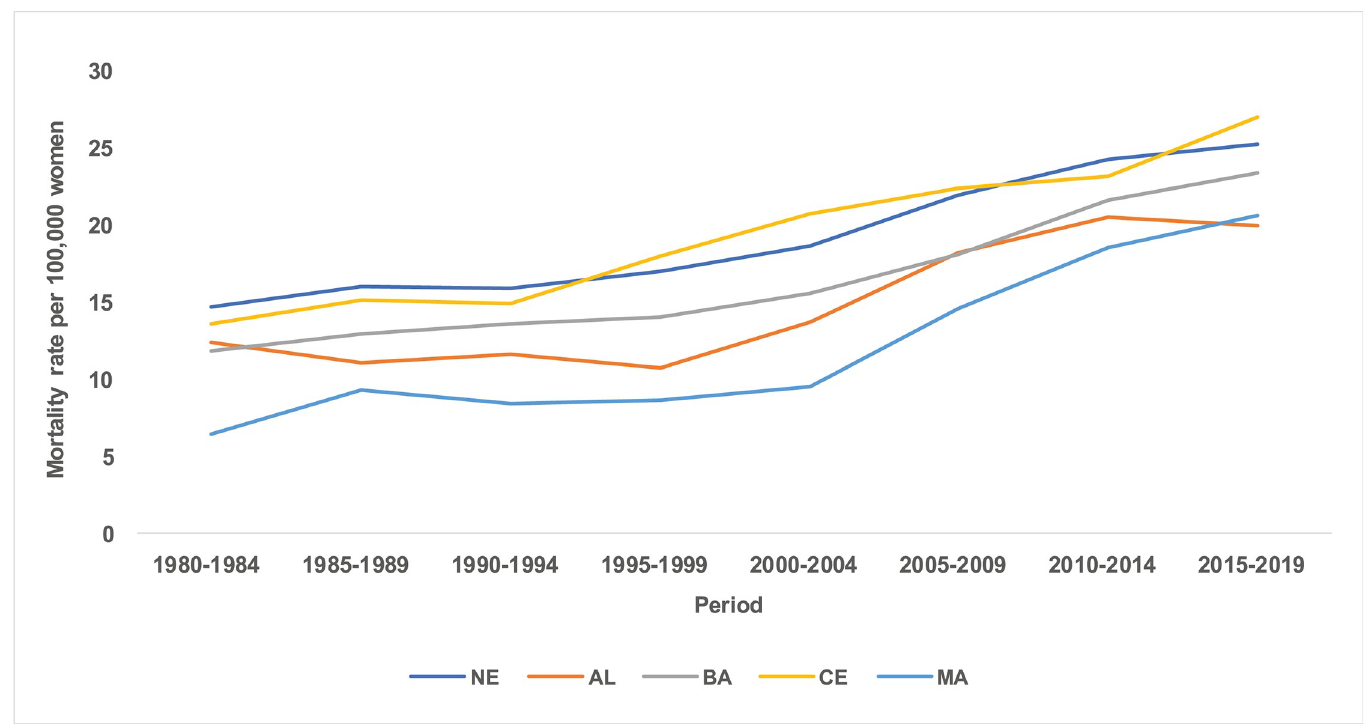
Fig 3. Mortality rates for breast cancer in the Northeast states of Brazil, by period 1980 to